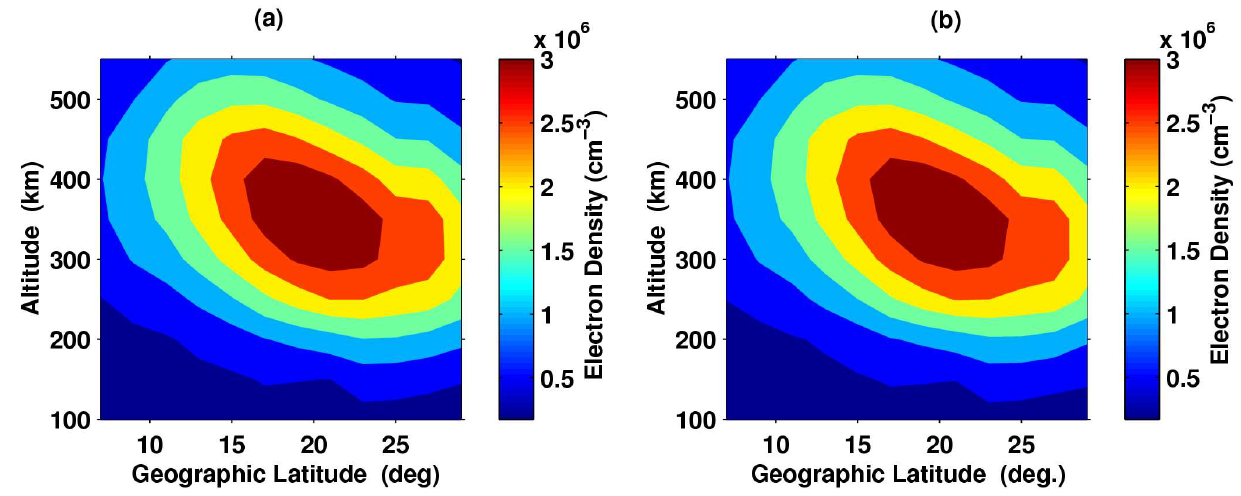
Fig. 5. ( a ) Same as Fig. 2a but with an enhanced electron density. ( b ) Same as Fig. 2b but with an enhanced electron density.